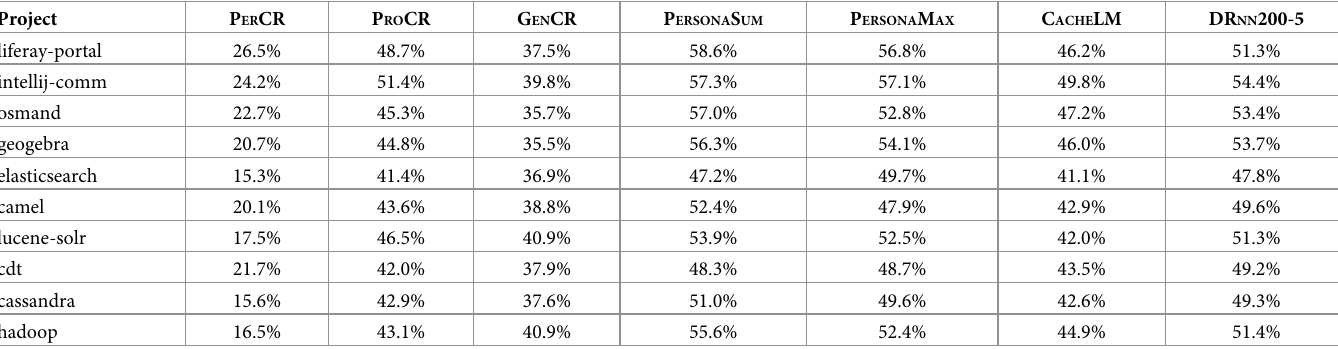
Table 6. Recommendation accuracy of lower-contributed programmers in selected projects.